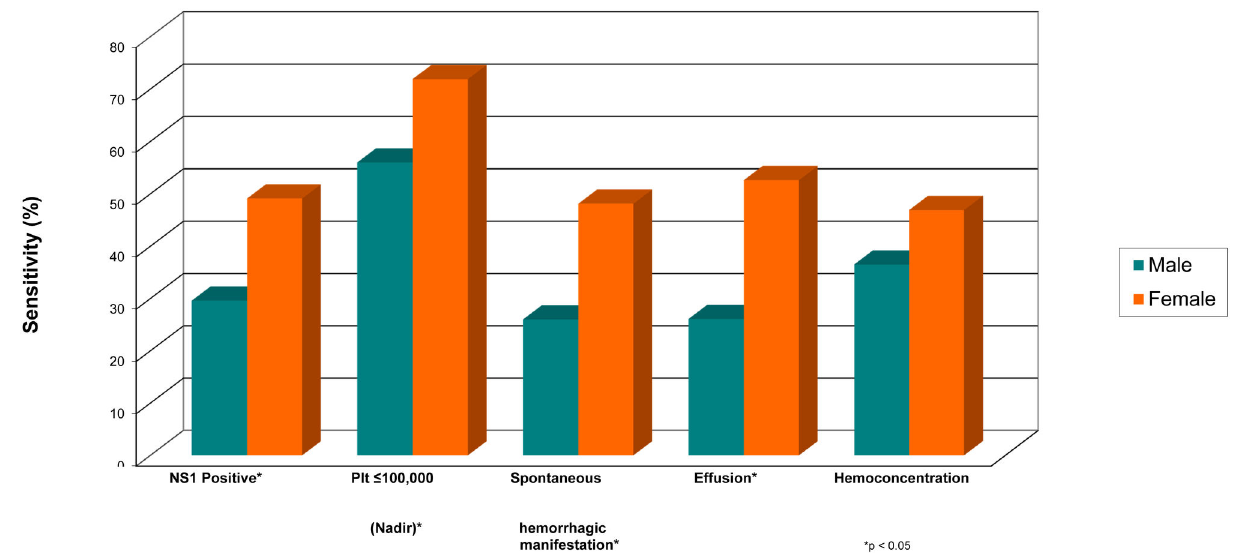
Figure 2. The sensitivity of the NS1 antigen test according to gender and clinical variables in secondary infections. doi: